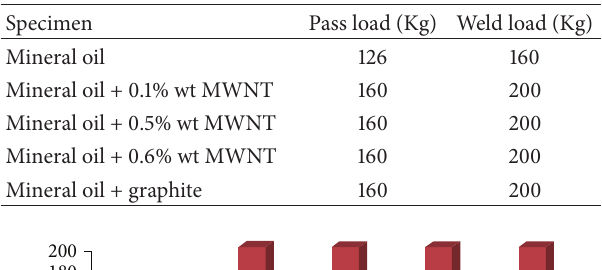
Table 2: Pass load and weld load values from the four-ball test.